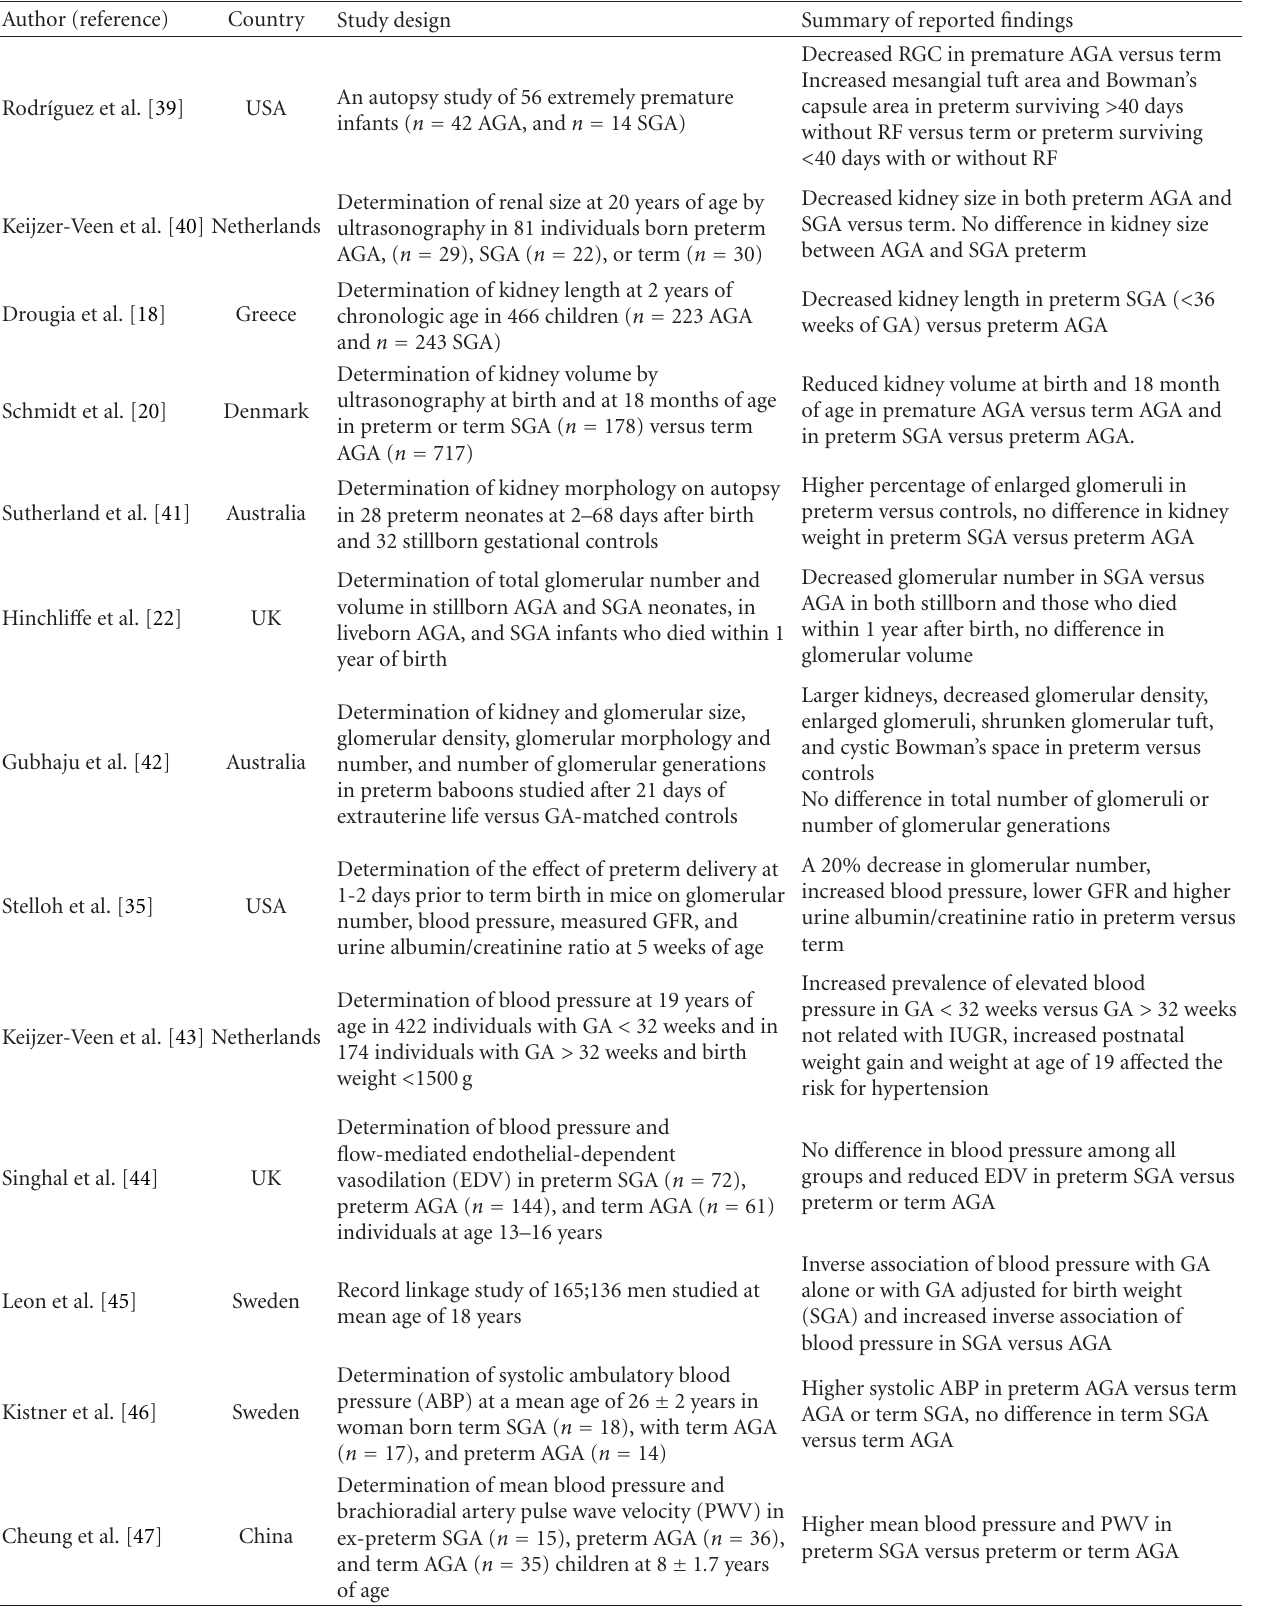
Table 1: E ff ect of prematurity alone or prematurity with IUGR on postnatal kidney growth, morphology, and programming of renal dysfunction and blood